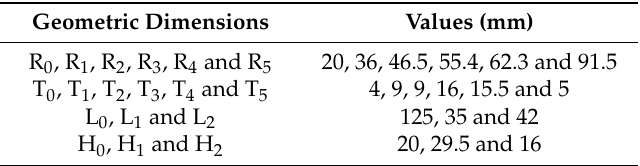
Table 2. Machine main geometric